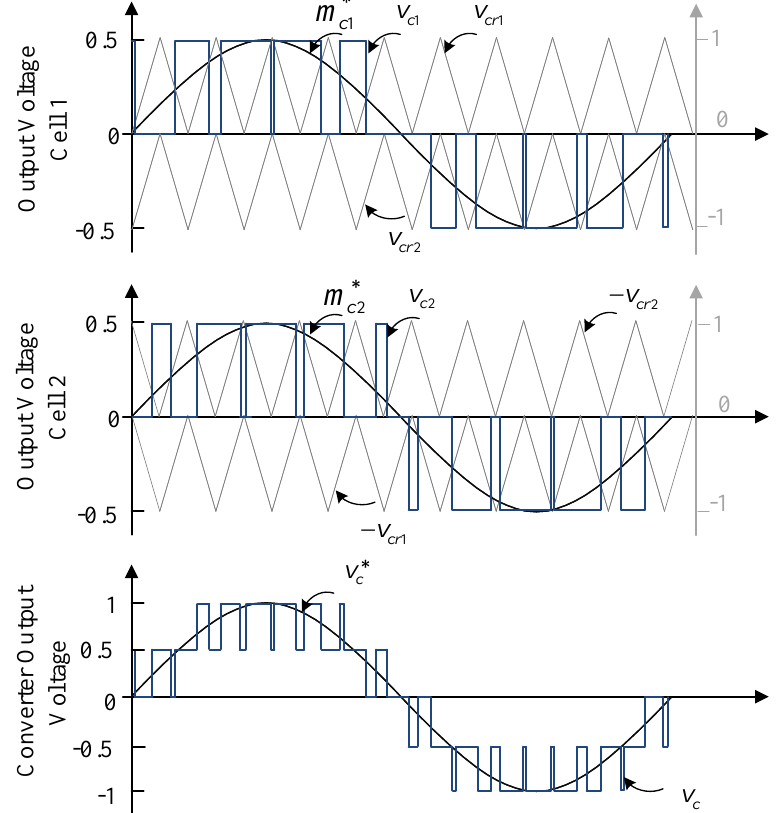
Figure 2. Proposed modulation scheme for 5L-CTNPC based on the hybrid LS-PWM and